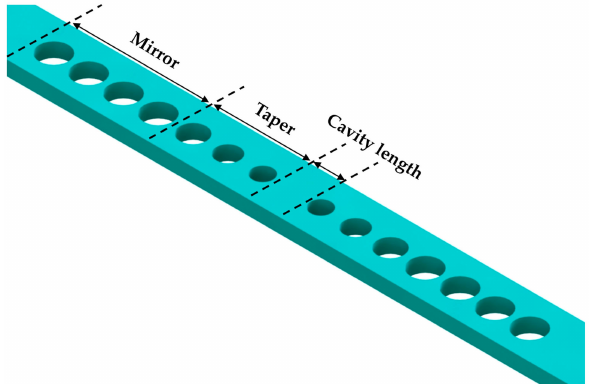
Figure 3. Three elements involved in the optimization of PhC nanobeam cavities.